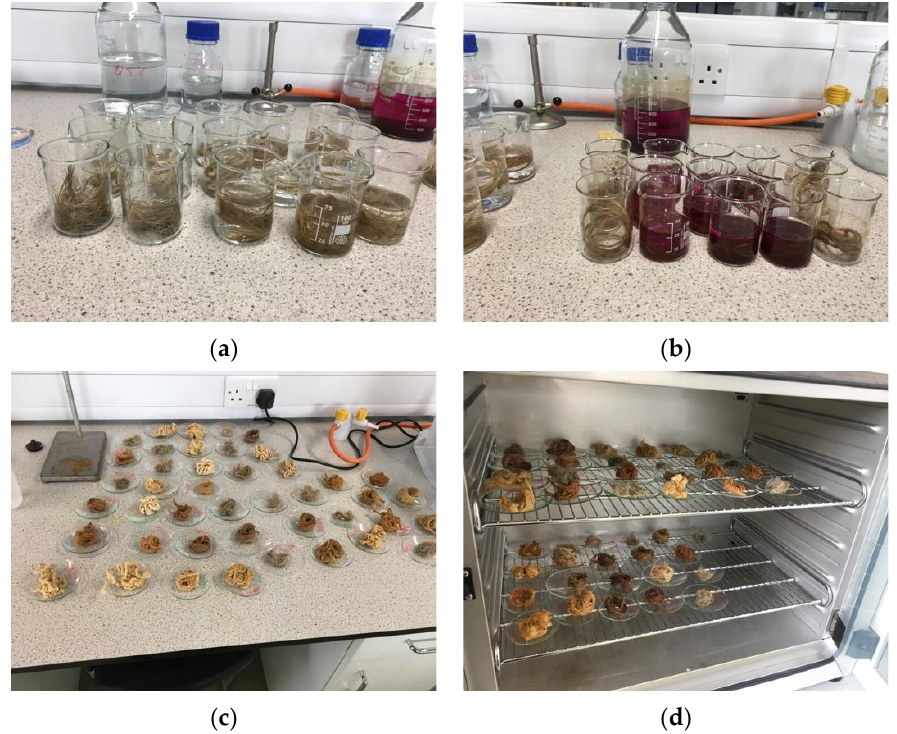
Figure 3. Surface treatments conducted on the fibres: ( a ) Fibres under surface treatments, ( b ) Fibres under surface treatments, ( c ) Fibres neutralised and ready to dry and ( d ) Fibres in the oven.